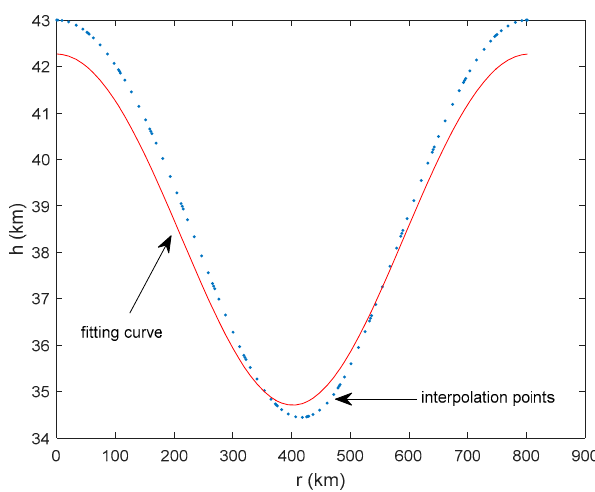
Appl. Sci. 2020 , 10 , x FOR PEER REVIEW Figure 6. Optimal periodic altitude at the initial altitude of 43 km. Figure 6. Optimal periodic altitude at the initial altitude of 43 km.